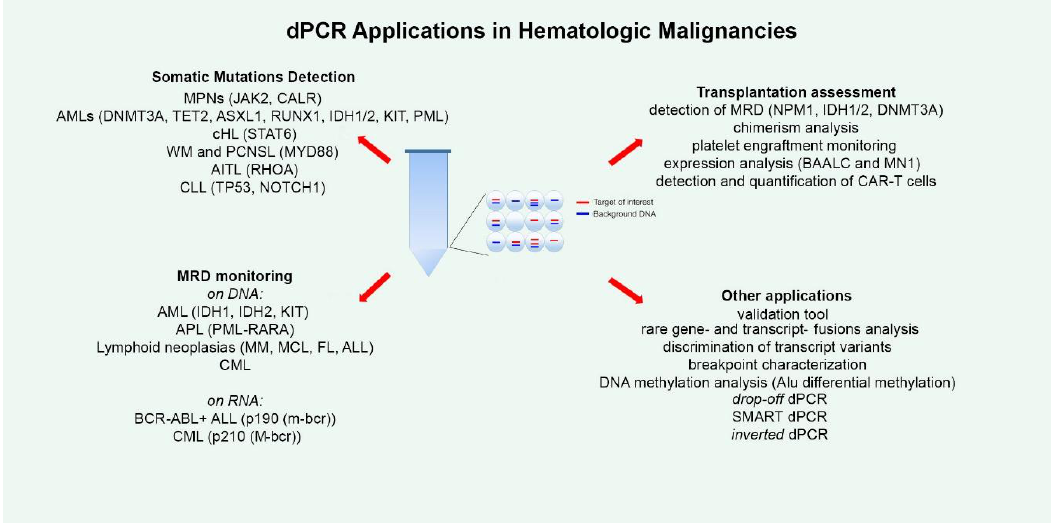
Figure 1. The figure summarizes all the current applications of droplet digital polymerase chain reaction (dPCR) technology explored in the field of hematology. For each disease, the studied alterations are indicated in round brackets. MPNs - Myeloproliferative Neoplasms; AML - Acute Myeloid Leukemias; cHL - Classical Hodgkin Lymphoma; WM - Waldenström Macroglobulinemia; PCNSL - Primary Central Nervous System Lymphomas; AITL - Angioimmunoblastic T-Cell Lymphoma; CLL - Chronic Lymphocytic Leukemia; MRD – Minimal Residual Disease; APL – Acute Promyelocytic Leukemia; MM - Multiple Myeloma; MCL - Mantle Cell Lymphoma; FL - Follicular Lymphoma; ALL – Acute Lymphoblastic Leukemia; CML – Chronic Myeloid Leukemia; SMART-ddPCR - Somatic Mutation Allelic Ratio Test-ddPCR.